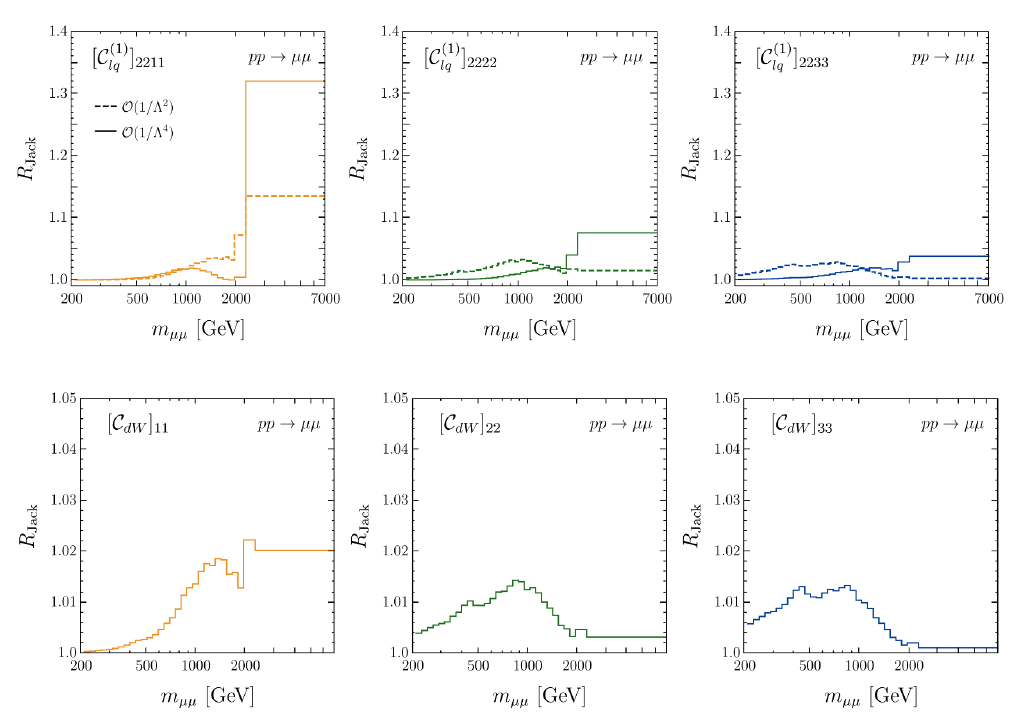
Figure 6. The expected sensitivity of individual m µµ bins to the dimension- 6 flavor conserving operators O (1) and O using the Jack-knife ratio R (see text for details). The dashed and dW Jack lq solid lines correspond to the EFT truncation at O (1 / Λ 2 ) and O (1 / Λ 4 ) ,